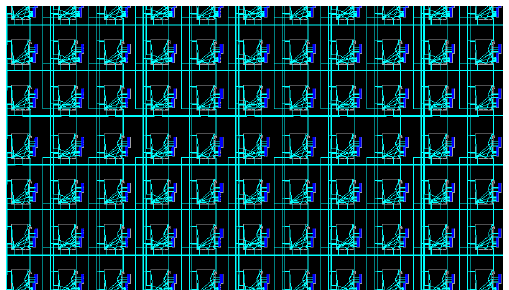
Figure 21. Test pattern of the hex line & PIPs along the oblique direction.